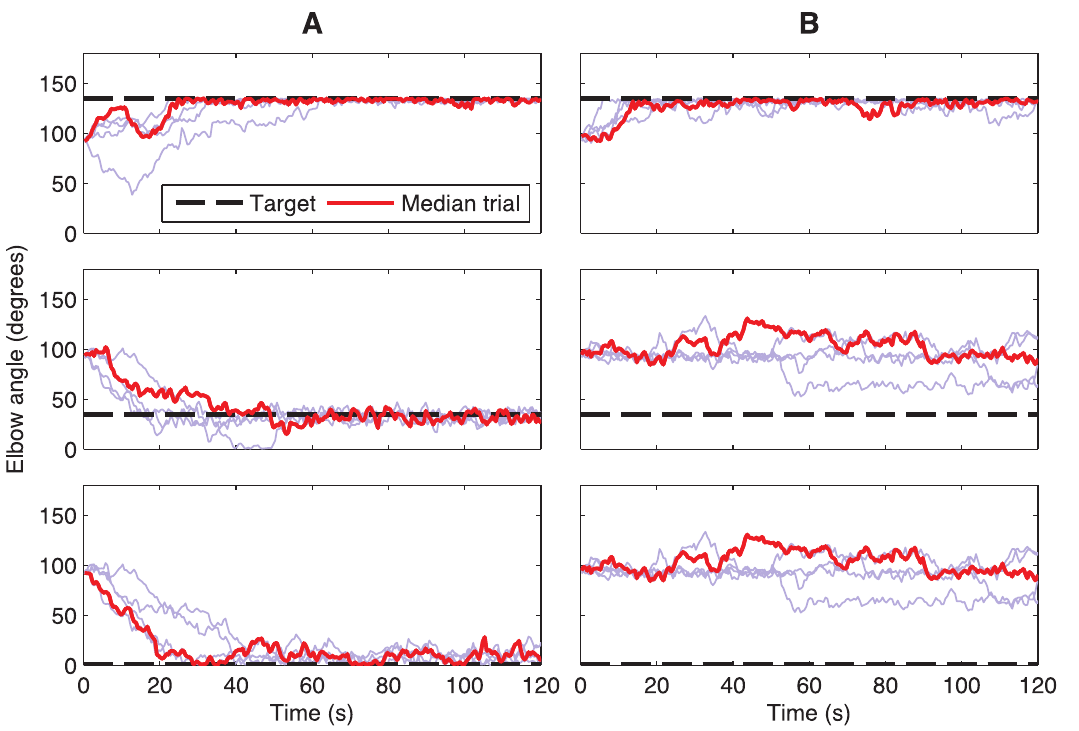
Figure 4. Target learning for two model wirings. Columns A and B show different wiring seeds, while each panel shows 5 different babble input random seeds with median final performance in red (calculated over 100–200 s; only 0–120 s shown).